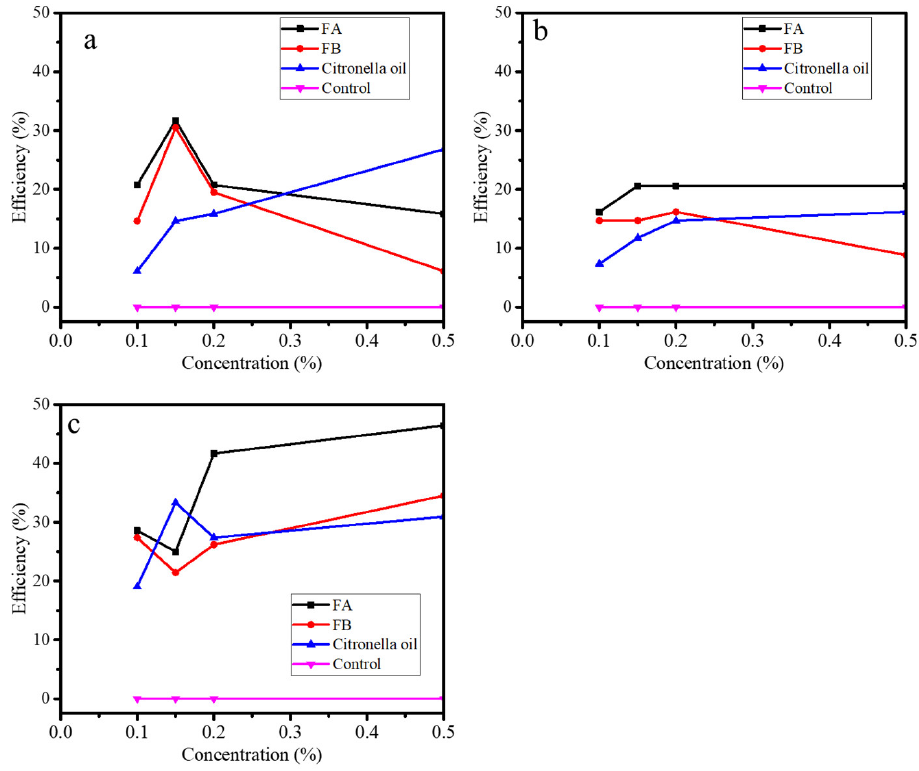
Figure 3. Effect of bio-additive concentration on fuel consumption efficiency for. ( a ) Pertamina-dex ( b ) Dexlite ( c ) Biosolar.